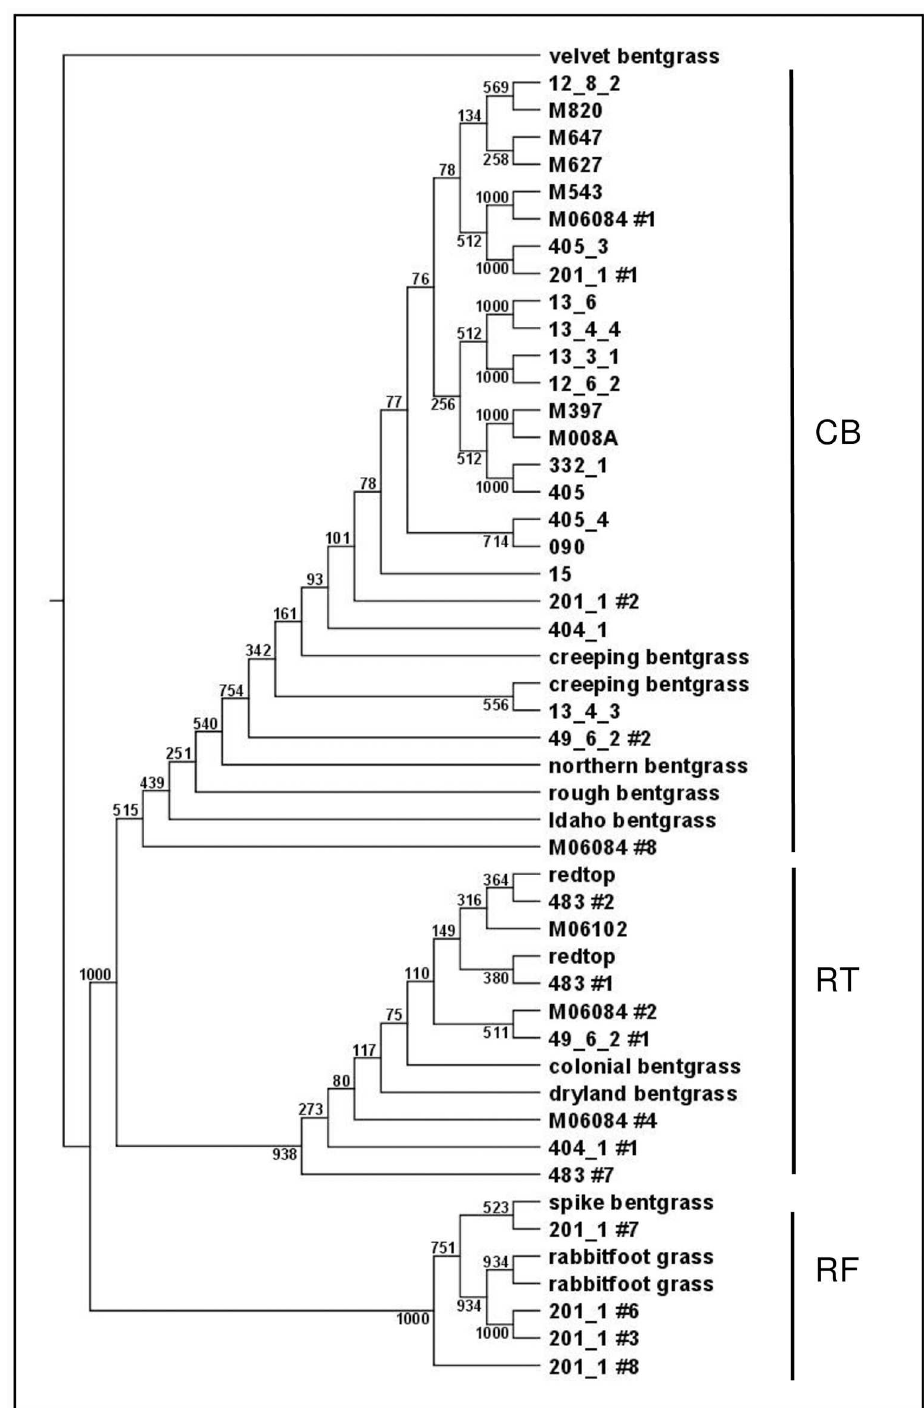
Fig 3. Bootstrapped UPGMA tree for ITS sequences. The numberfollowing# is the clone number presented when sequenceswere different. The number followingthe last underscore impliesthe plant survived the greenhouse screening. No underscore means the mother plant, except for 15 that was a single seedling(15_1). Numbers on branchesare Bootstrap values.